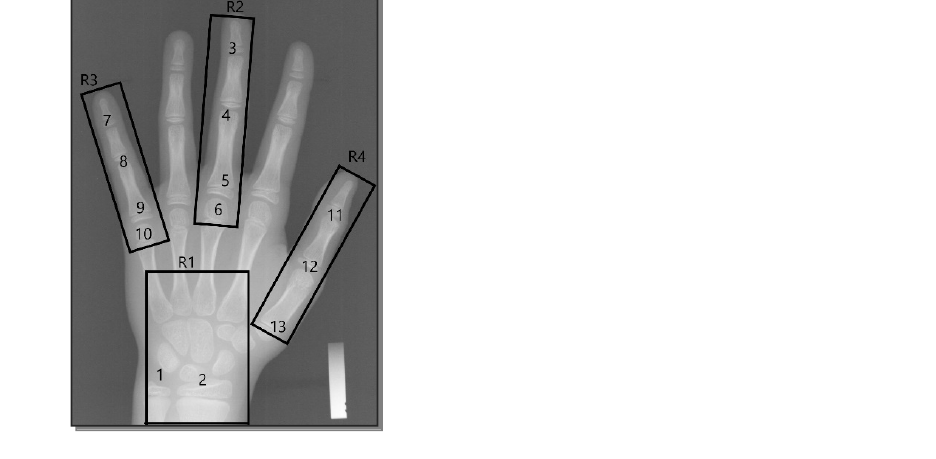
Figure 1. Numbers 1 to 13 indicate the ROI regions in the TW method (R1 to R4 regions extracted from DHA